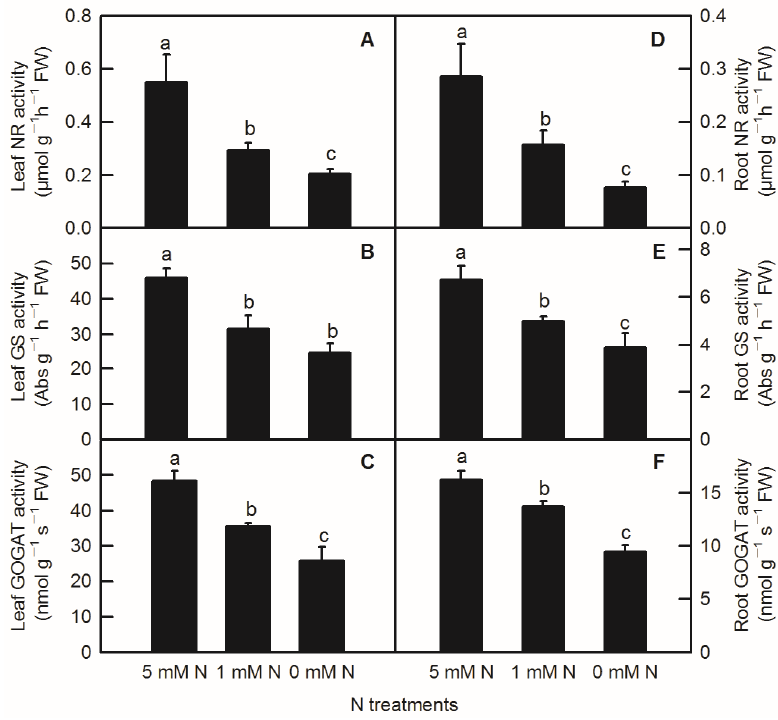
Figure 5. Effects of N deficiency on the activities of enzymes related to N metabolism in O. sativa leaves( A – C ) and roots ( D – F ). Bars represent means ± SD ( n = 3). Difference among the treatments was analyzed by Duncan’s multiple range test. Different letters above the bar indicate a significant difference at p < 0.05.